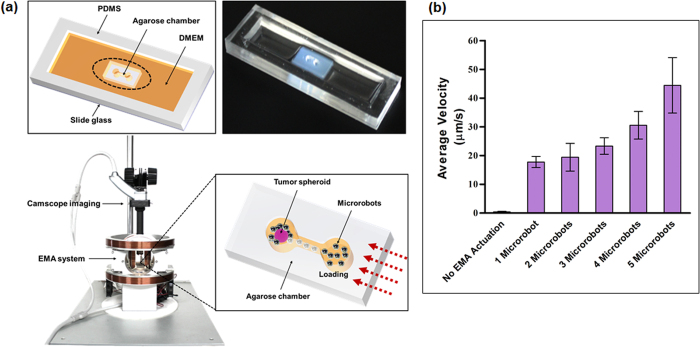
Motility enhancement of macrophage-based microrobots in a channel.(a) (top) Microfluidic channel for evaluating tumor-targeting properties of macrophage-based microrobots; (bottom) comprehensive system for external active actuation and imaging of macrophage-based microrobots (bottom). (b) Velocities of the microrobots showing different speeds by number of aggregated cells.